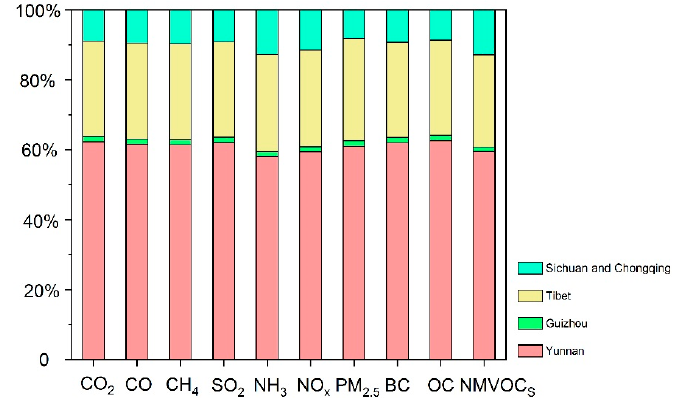
Figure 6. The annual average contributions of forest fire emissions in each province from 2013 to 2017.